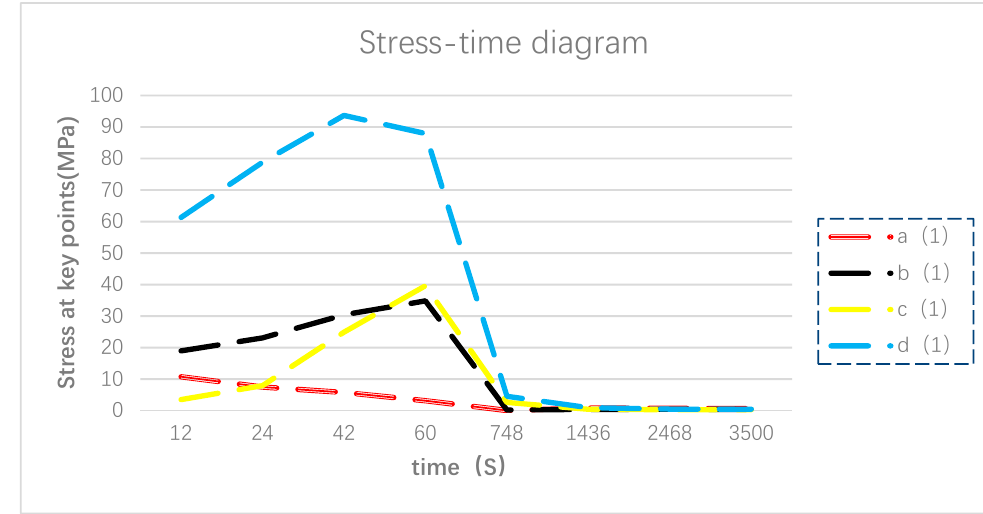
Figure 10. Stress at the four critical points of the pressure plate under the first type of constraint. Table 2. Stresses at the four critical points of the pressure plate under the first type of constraint.